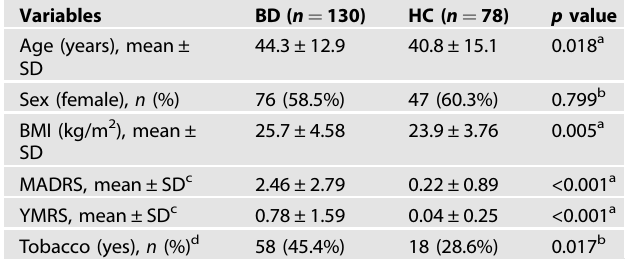
Table 1. Characteristics of individuals with bipolar disorders and healthy controls